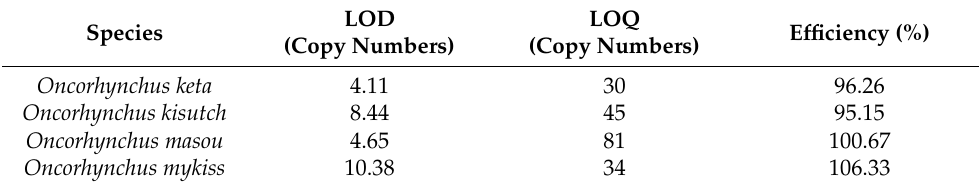
Figure 2. Calibration curves generated from serially diluted target samples using ten replications: ( A ) O. keta , ( B ) O. kisutch , ( C ) O. masou , and ( D ) O. mykiss . The vertical solid red and broken black line, respectively, represent the limit of detection (LOD) and the limit of quantification (LOQ). Table 2. The sensitivity and efficiency of four Oncorhynchus